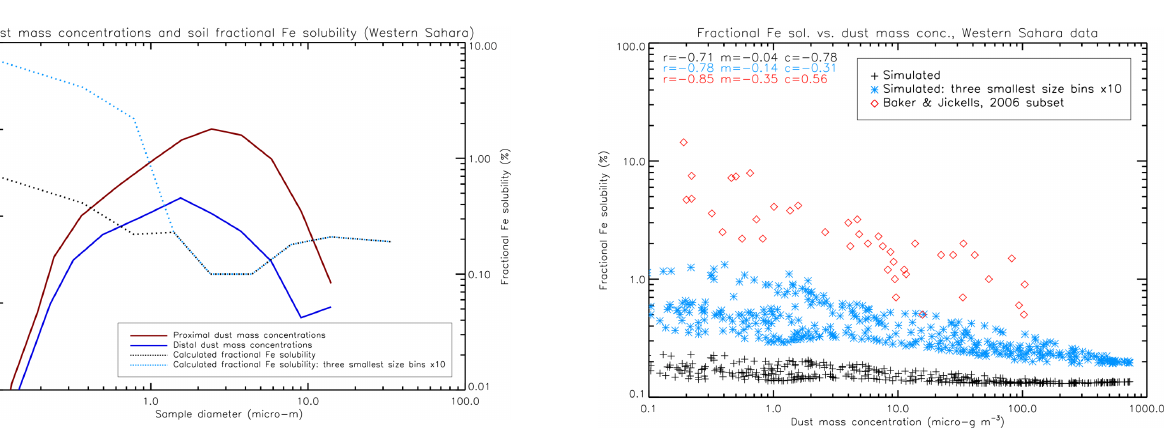
Fig. 6 Variations of fractional Fe solubility (FS-Fe) with dust mass concentration. Red datapoints are a subset of the Baker and Jickells (2006) dataset. Black datapoints Fig. 6. Variations of fractional Fe solubility (FS-Fe) with dust mass are the FS-Fe calculated by combining the measured size-resolved FS-Fe from the concentration. Red datapoints are a subset of the Baker and Jickells Western Sahara sample with GLOMAP outputs (size-resolved dust mass (2006) dataset. Black datapoints are the FS-Fe calculated by com- concentrations). Blue datapoints are the FS-Fe calculated in the same way but with bining the measured size-resolved FS-Fe from the Western Sahara the measured FS-Fe of the three smallest size fractions (0.18-0.32 µm; 0.32-0.56 µm; sample with GLOMAP outputs (size-resolved dust mass concentra- and 0.56-1.0 µm) increased by a factor of ten. Summary statistics at the top left of tions). Blue datapoints are the FS-Fe calculated in the same way but the figure are discussed in the text. with the measured FS-Fe of the three smallest size fractions (0.18– 0.32µm; 0.32–0.56µm; and 0.56–1.0µm) increased by a factor of ten. Summary statistics at the top left of the figure are discussed in the